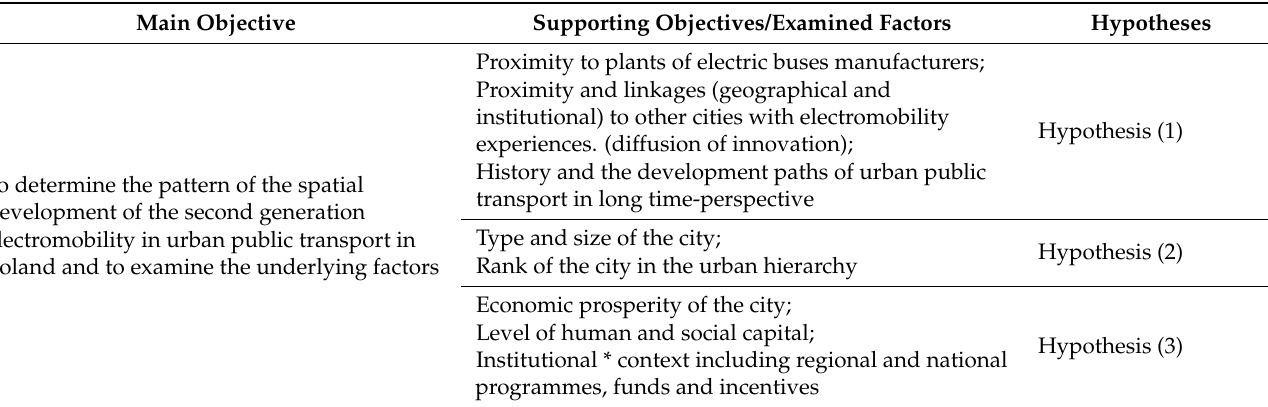
Table 1. Research objectives and corresponding